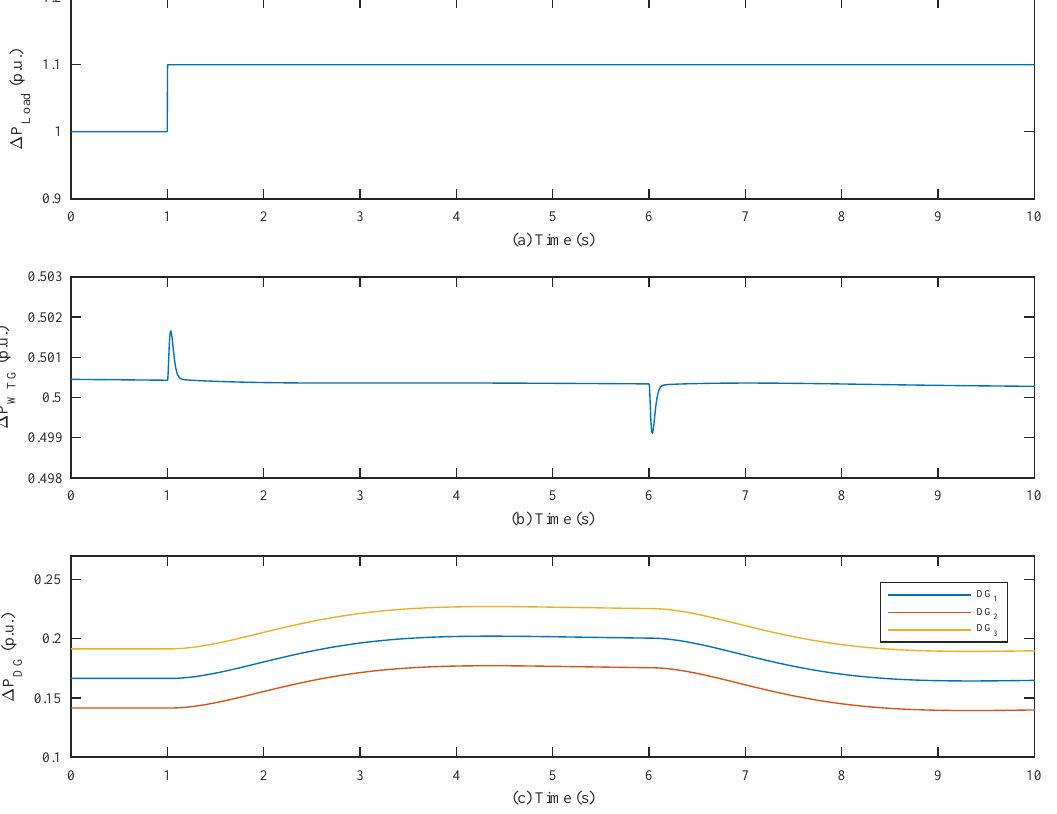
Figure 11. Transient power output of each source. ( a ) Load demand output; ( b ) power of WTG; ( c ) power of